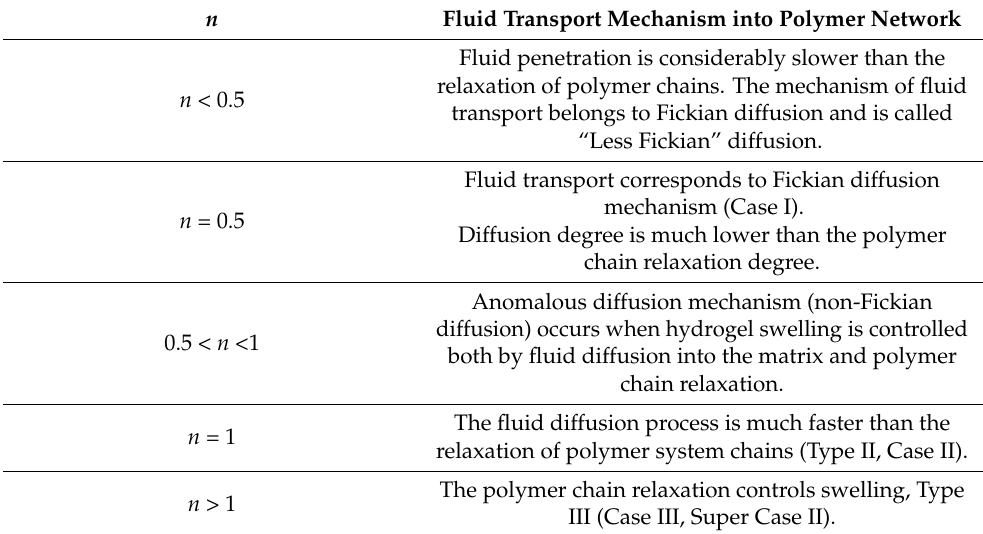
Table 1. The Fluid Diffusion Mechanism Related to the Value of Diffusion Exponent, n. n Fluid Transport Mechanism into Polymer Network Fluid penetration is considerably slower than the relaxation of polymer chains. The mechanism of fluid n < 0.5 transport belongs to Fickian diffusion and is called “Less Fickian” diffusion. Fluid transport corresponds to Fickian diffusion mechanism (Case